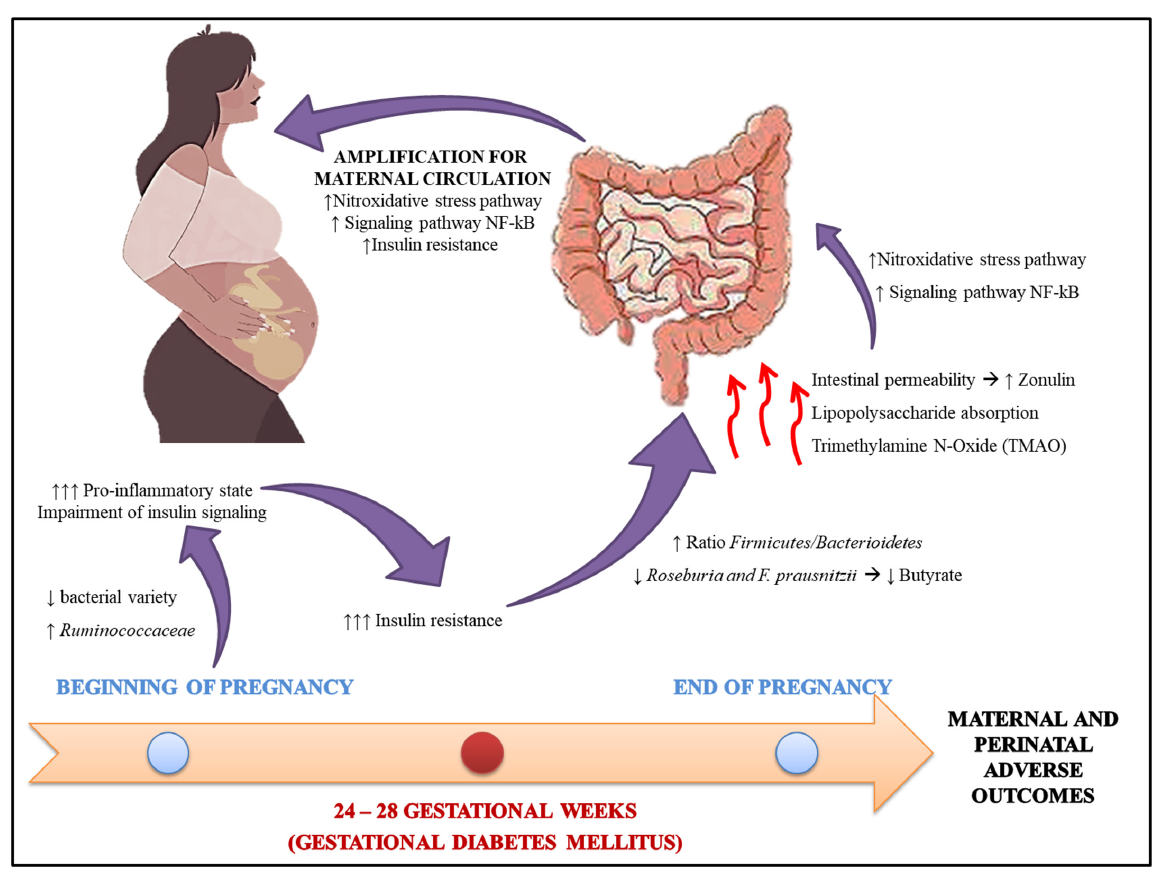
Figure 2. Scheme of the interaction between GDM and intestinal microbiota, inflammatory, and oxidative stress processes .